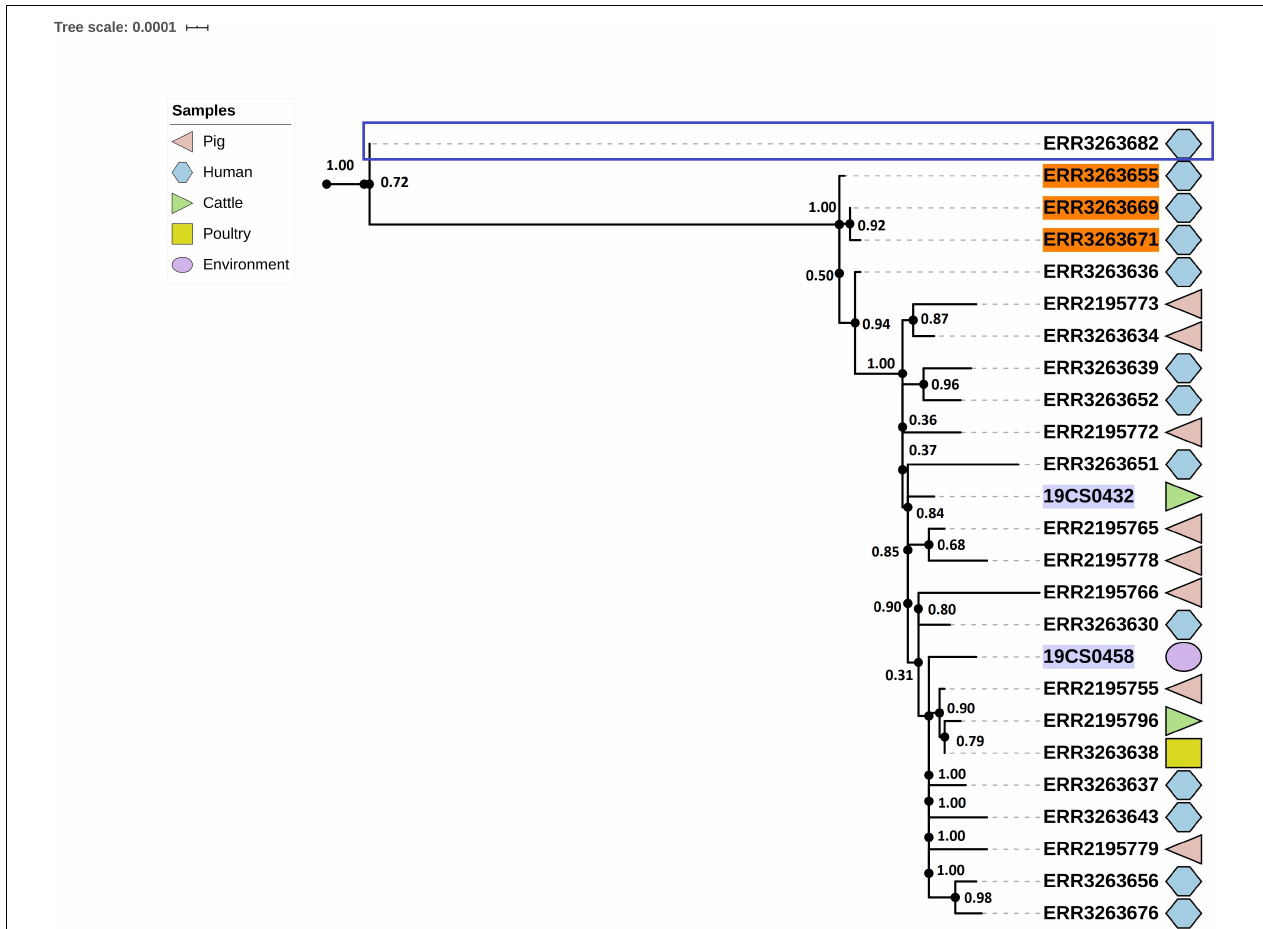
FIGURE 5 | Phylogenetic SNP-based tree of S. Derby ST682 strains. Cluster 1 (blue rectangle) and cluster 2 (rest of the sequences, not labeled). The colored zone alongside the tree indicates the source of the isolates: pig (pink), human (blue) cattle (green), environment (purple), and poultry (yellow). FLI isolates marked in purple. Human isolates of the 2013 outbreak are highlighted in